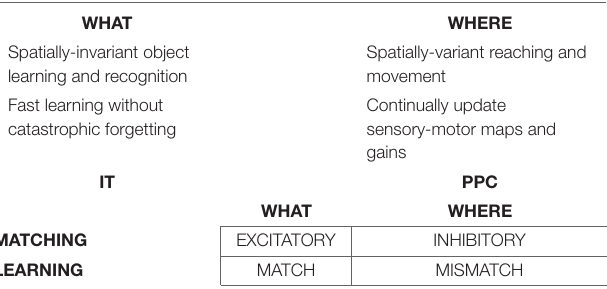
TABLE 1 | The What ventral cortical stream and the Where dorsal cortical stream realize complementary computational properties. See the text for details [reprinted with permission from Grossberg